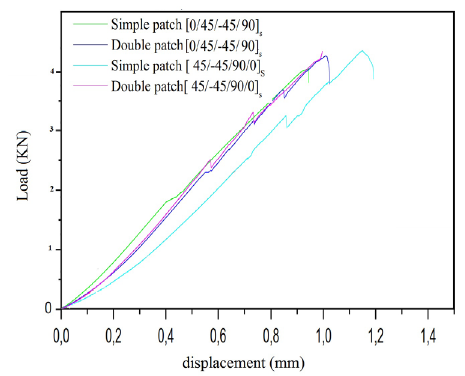
Figure 7. Repair by glass / epoxy patch.